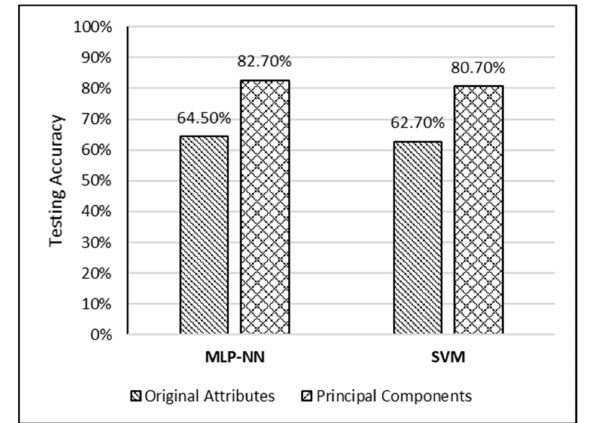
Figure 9. Testing classification accuracies for the developed